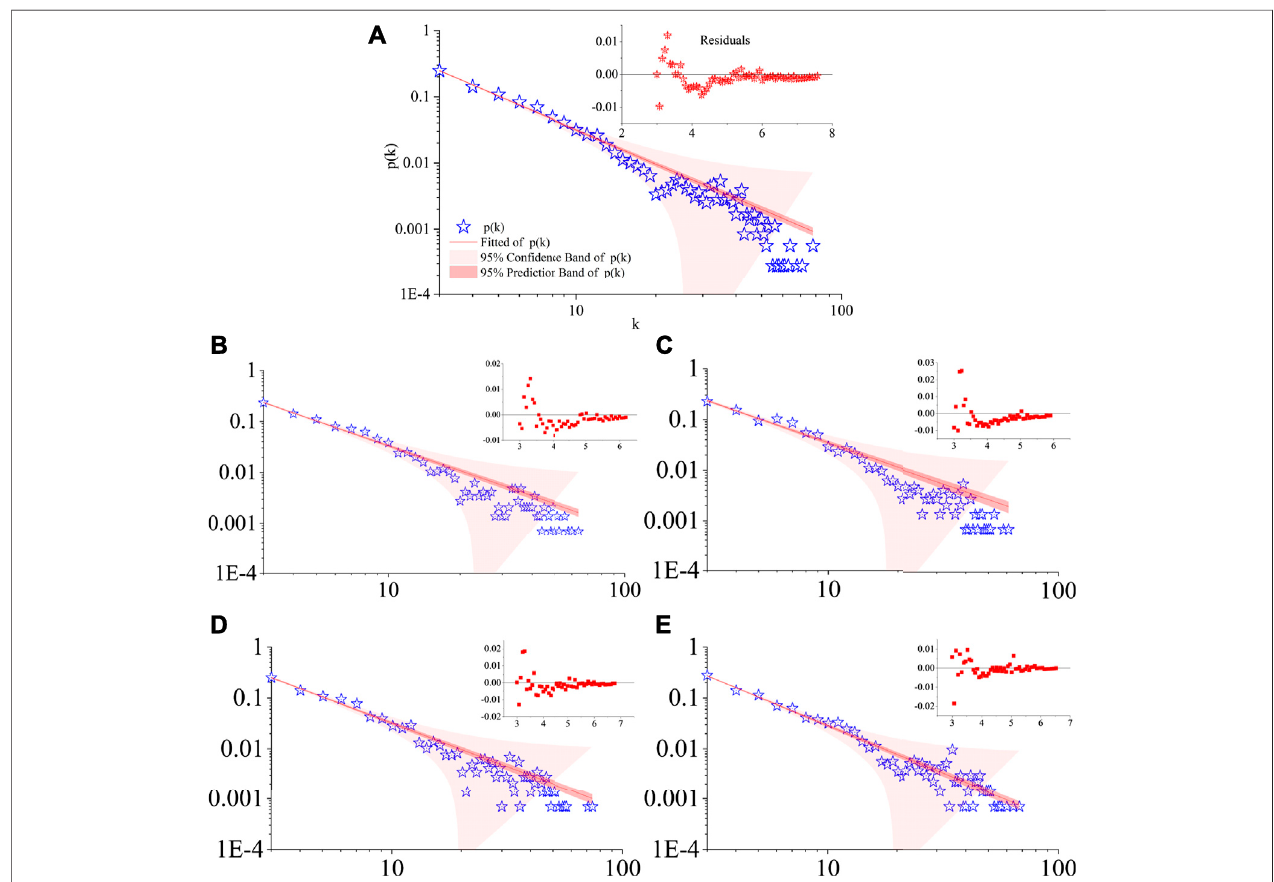
FIGURE 4 | Degree distribution of networks. (A) is a global network, and (B – E) window network with a length of 4 years. In fi gures (A – E) , the abscissa is the logarithm of degree with the base of 10, and the ordinate is the logarithm of frequency. The upper right corner of each pair is the fi tting residual.